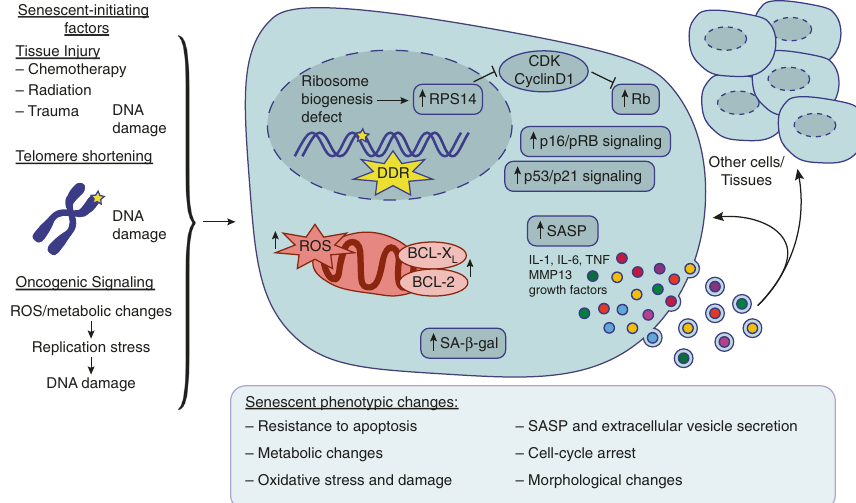
Fig. 1 Overview of senescence. Several factors can induce senescence in different tissues, such as tissue injury, telomere shortening, and oncogenic signaling that all lead to DNA damage, the DNA damage response (DDR), and consequent cell cycle arrest by activation of p16/pRB signaling and/or p53/p21 signaling. Nucleolar stress and ribosome biogenesis defects can also induce RPS14 accumulation in the nucleus and activates Rb by inhibiting the CDK4/cyclin D1 complex, leading to cell cycle arrest. Senescent cells also exhibit increased senescence- associated β -galactosidase (SA- β -gal) production, reactive oxygen species (ROS) accumulation, and anti-apoptotic factors such as BCL-X L and BCL-2. Senescent cells exhibit several phenotypic changes such as a resistance to apoptosis, oxidative stress and damage, metabolic changes, morphological changes, cell cycle arrest, and extracellular vesicle secretion containing SASP factors such as IL-1, IL-6, TNF, MMP13, and various growth factors. This SASP can either feedback in an autocrine manner to the senescent cell or in a paracrine manner in fl uence and promote senescence and in fl ammation in the surrounding cells and